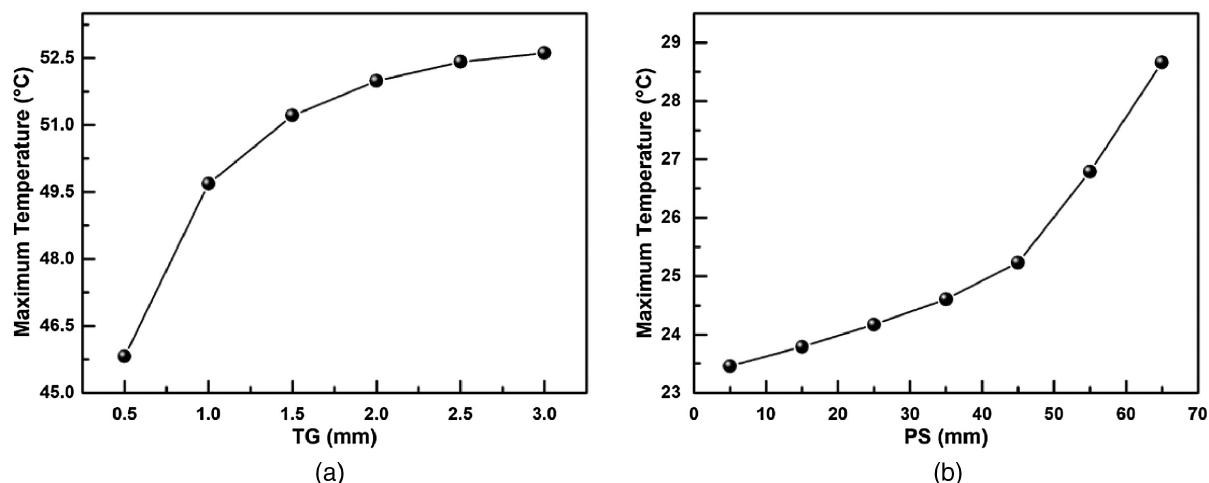
FIG. 16. (a): Relationship between tuner gap (TG) and maximum tuner temperature when no rf sealing; (b): Relationship between rf sealing position (PS) and maximum tuner